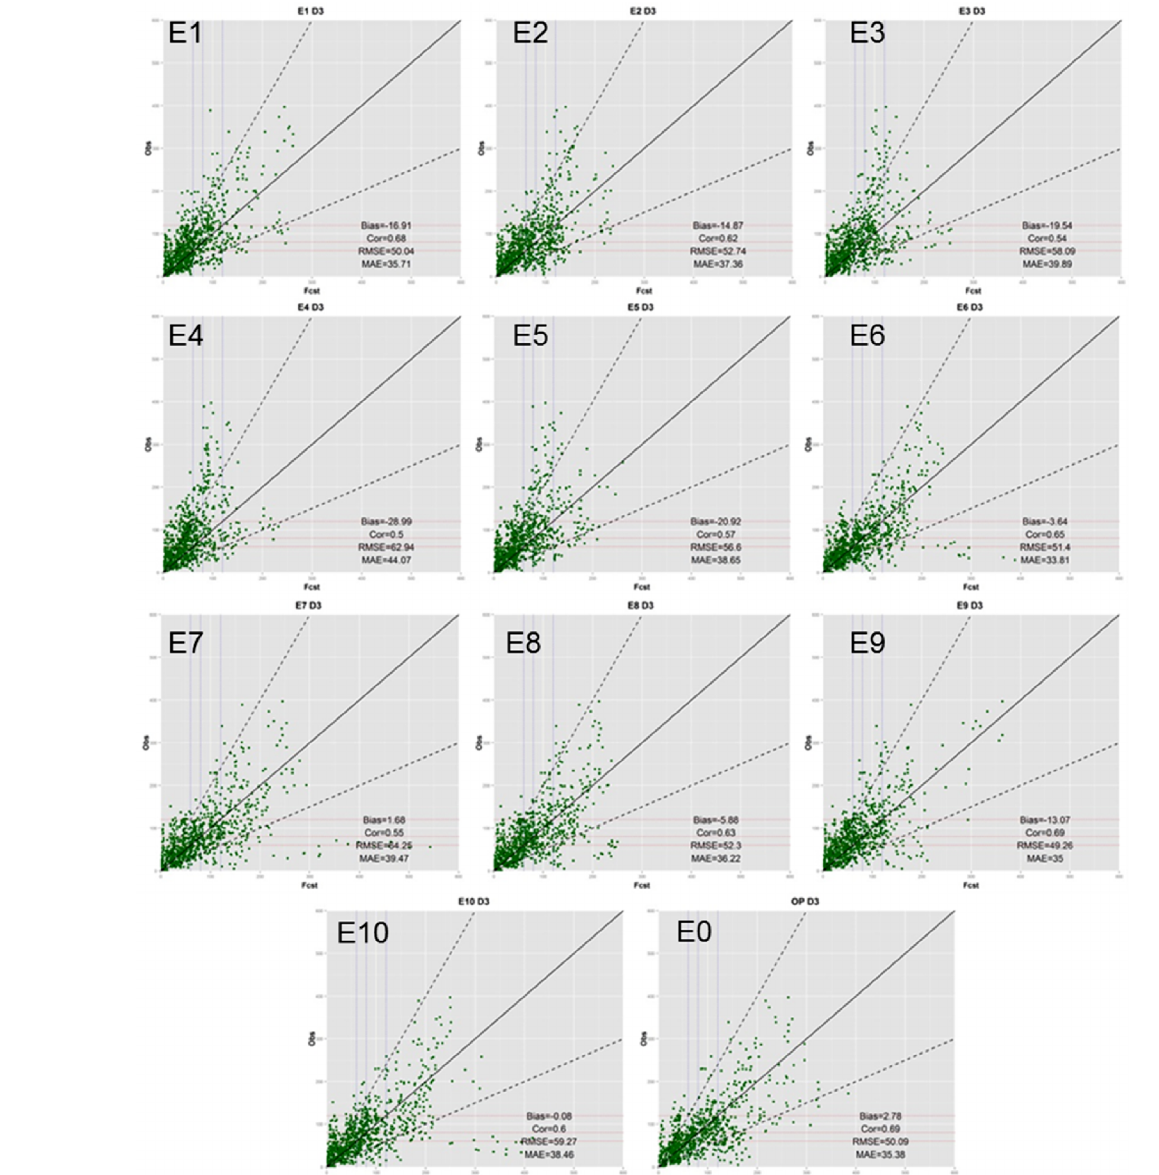
Figure 2. Scatterplots of precipitation episodes, forecast versus observed, for the whole set of